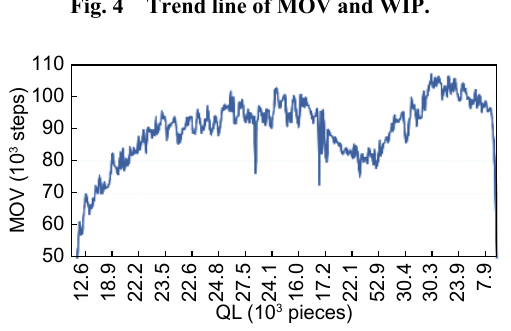
Fig. 5 Trend line of MOV and QL.